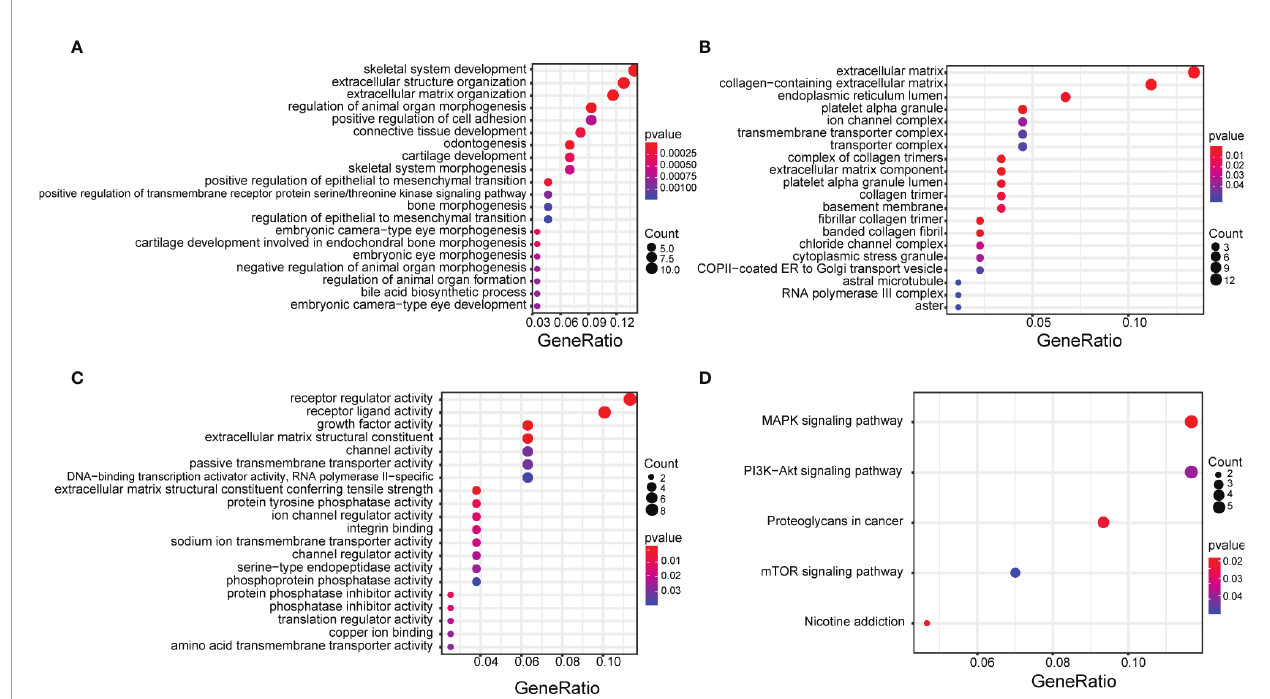
FIGURE 6 | GO enrichment analysis of target genes that function in biological processes (A) , cell composition (B) , molecular function (C) , and KEGG pathway enrichment analysis (D) . The size of each circle correlates with the number of genes in the pathway, and color depth represents the − log 10 (FDR) value. GO, Gene Ontology; KEGG, Kyoto Encyclopedia of Genes and Genomes.